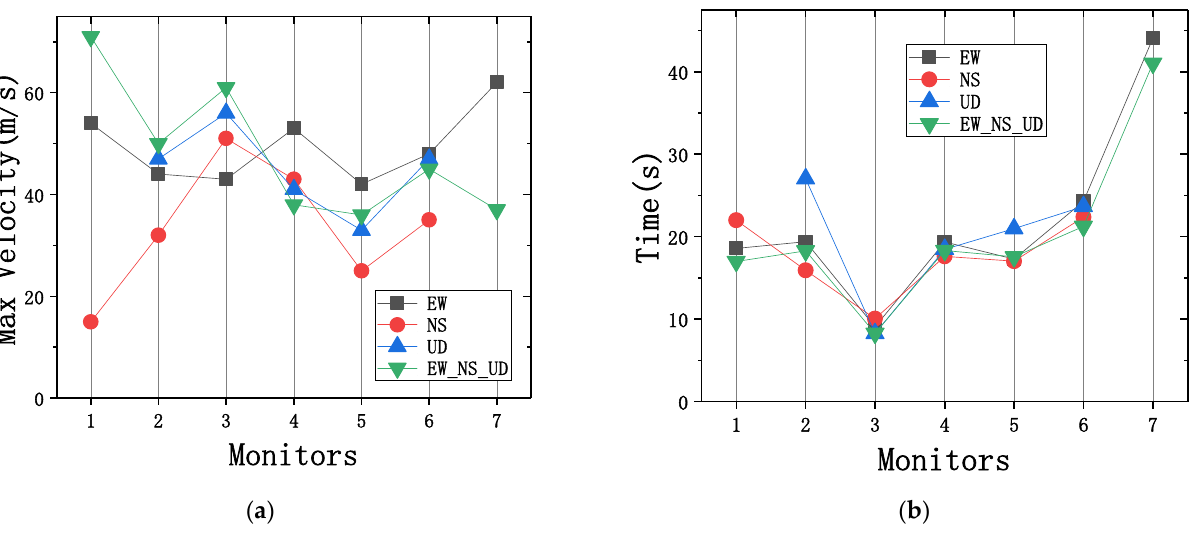
Figure 15. Comparison of maximum velocities of the monitors ( a ) and their appearance time ( b ) in 4 cases.